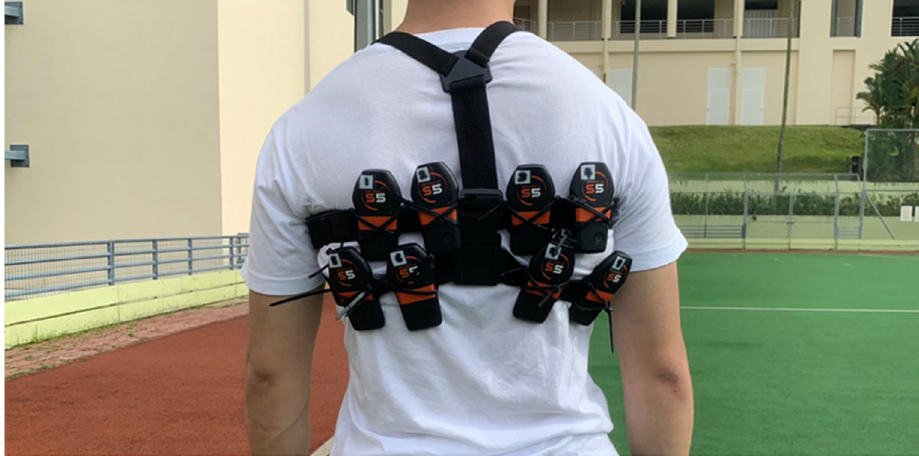
Figure 1. Each participant wore eight GNSS units at once in the maximal sprint test.